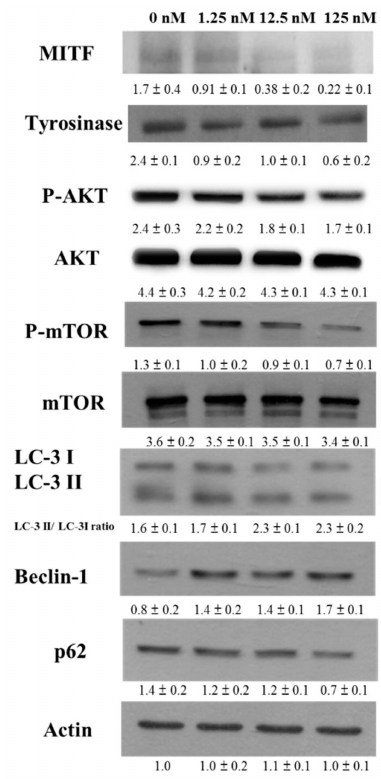
Figure 3. The expression levels of tyrosinase and microphthalmia-associated transcription factor (MITF) after hinokitiol treatment. B16F10 cells were treated with hinokitiol at the concentration of 1.25, 12.5 or 125 nM for 48 h. The protein expression was determined by immunoblotting. Inserted values indicated relative proteins expression in comparison with β -actin. Each experiment was repeated three times with similar results. (mean ˘ SD, n =